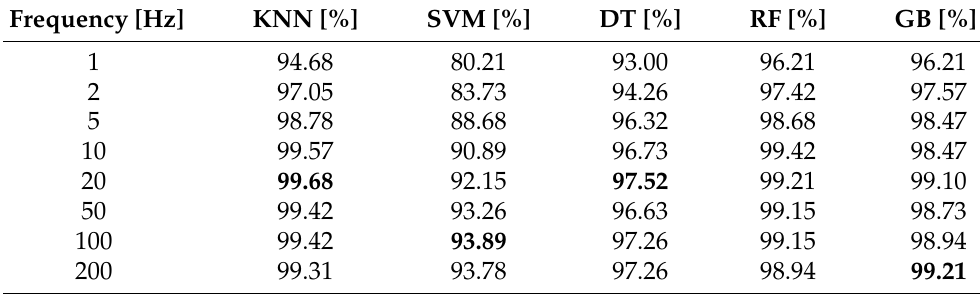
Table 6. Comparison of the Specificity across the ML algorithms, with the highest values in bold.